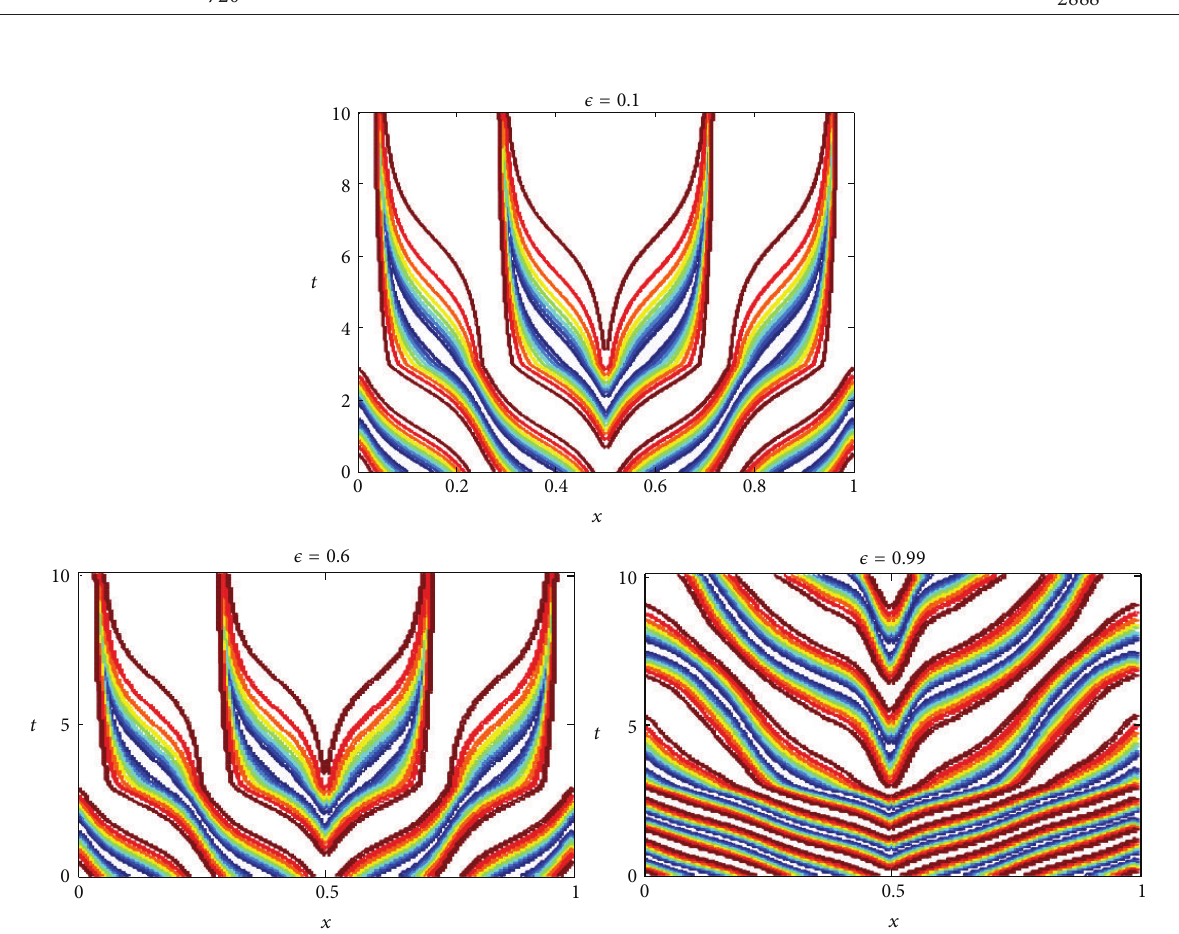
Figure 1: Here we present contour of cos (𝜃 ℎ (𝑥,𝑡) ) for 0 ≤ 𝑥 ≤ 1 , 0 ≤ 𝑡 ≤ 10 . Here we use 𝑁 = 128 space nodes to compute the spatial integrals, then we use Δ𝑡 = 0.1 for time integration, and we use modified Euler for time